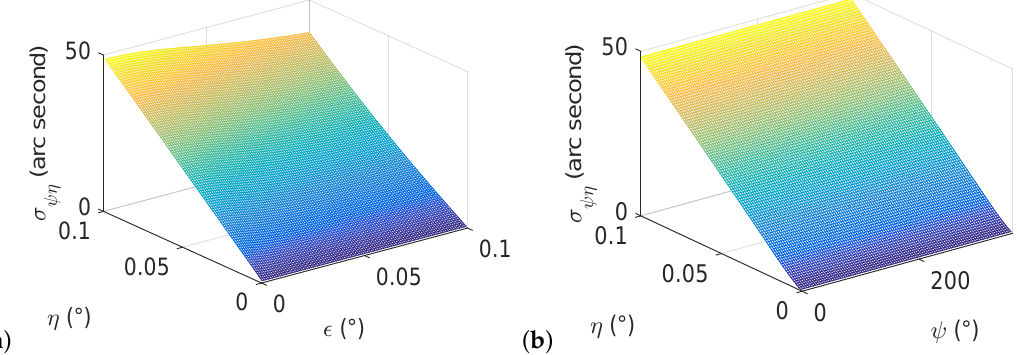
Figure 7. Azimuth uncertainty against shaft misalignment. ( a ) Azimuth uncertainty against shaft misalignment when ε ∈ [0.001 ◦ , 0.1 ◦ ] and ψ = 45 ◦ ; ( b ) Azimuth uncertainty against shaft misalignment when ψ ∈ [ 0 ◦ ,360 ◦ ] and ε = 0.01 ◦